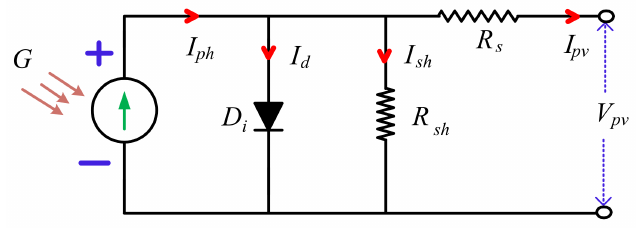
Figure 3. Equivalent model of a solar